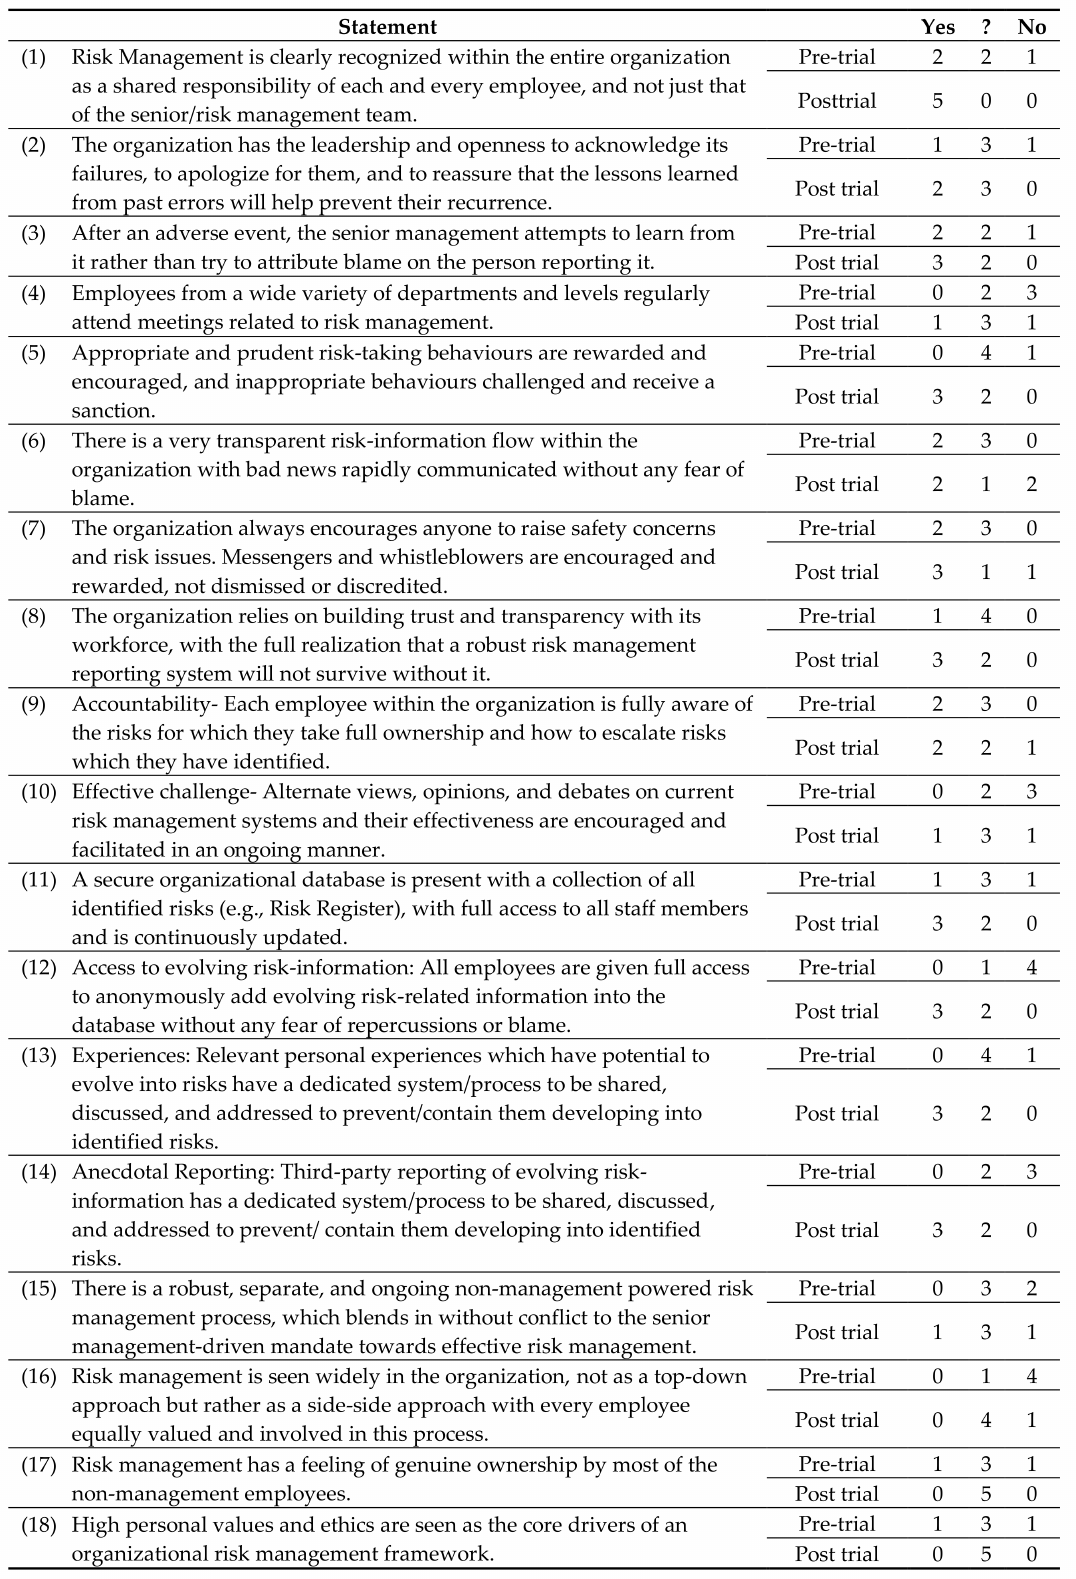
Table 5. Risk-Sentience Checklist—Collected